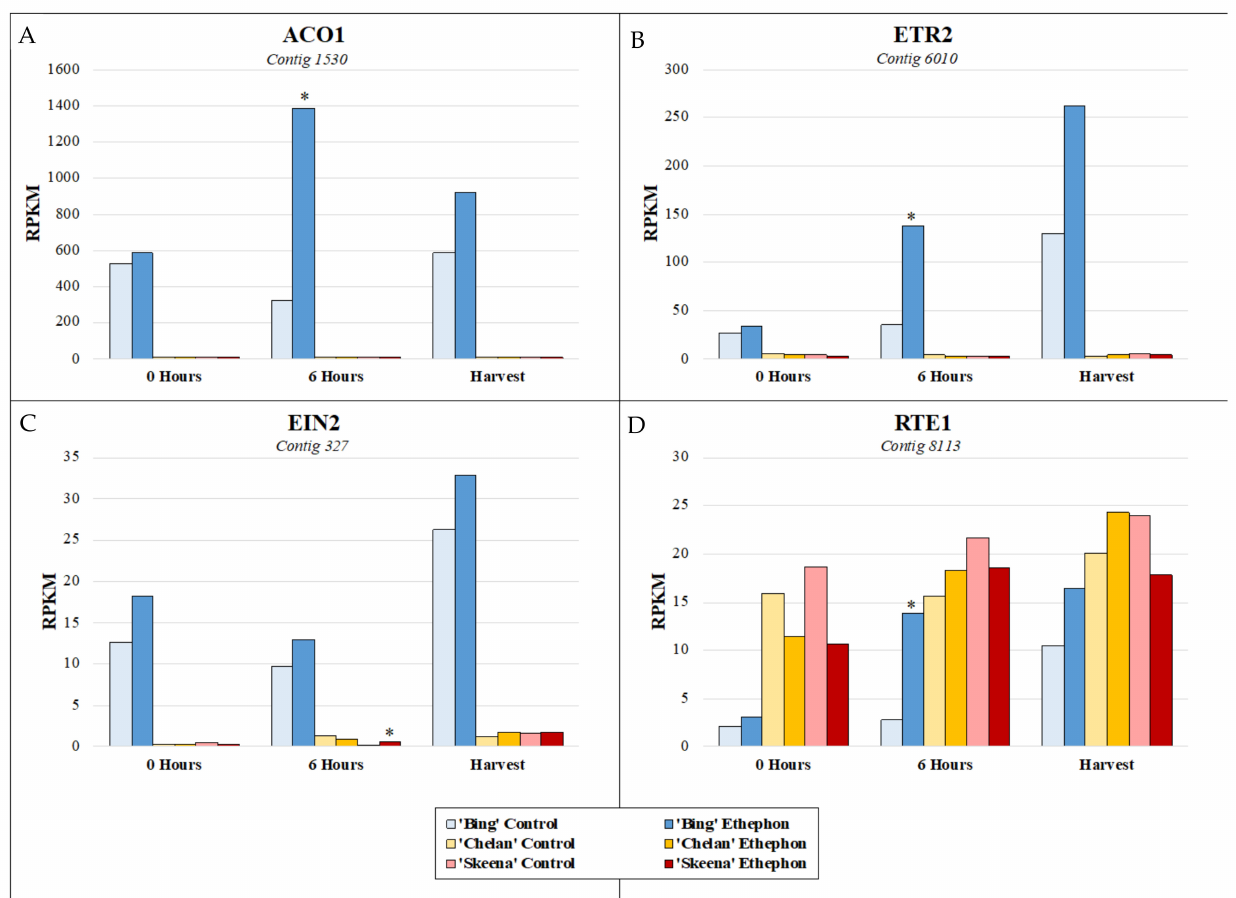
Figure 5. Expression patterns of ethylene biosynthesis gene ( A ) 1-aminocyclopropane-1-carboxylate oxidase 1 ( ACO1 ), ( B ) ethy- lene receptor 2 ( ETR2 ), and ( C ) signal transducer ethylene insensitive 2 ( EIN2 ), and ( D ) ethylene-negative regulatory protein reversion-to-ethylene-sensitivity 1 ( RTE1 ) at 0 h, 6 h post-ethephon treatment, and harvest. Asterisks indicate significant difference, according to both Kal’s Z-test ( p < 0.05) and NOIseq-sim (probability > 0.8) differential expression probability analysis and a |logFC| >